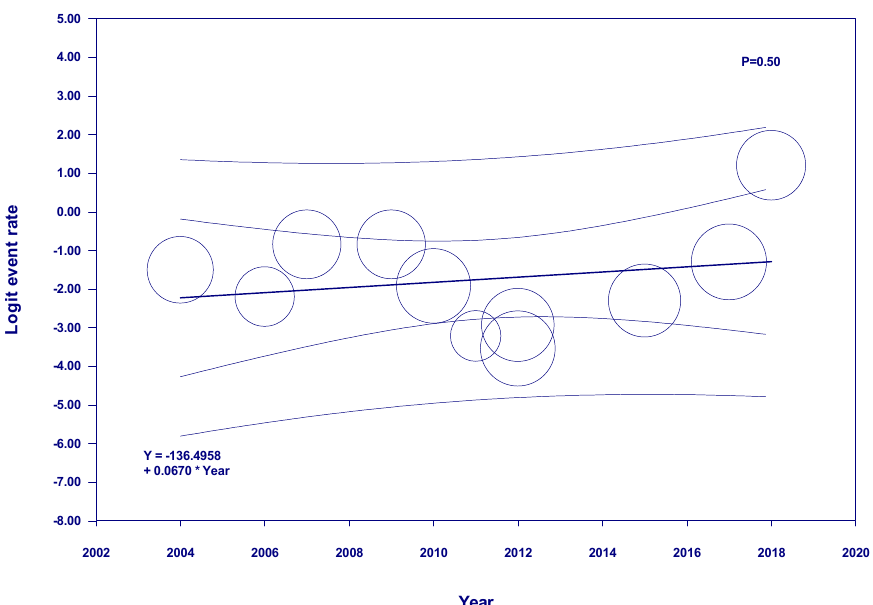
Figure 6. Meta-regression analyses showed no significant correlations between the year of study and mortality of patients with RCC ( P = 0.50). The solid line represents the weighted regression line based on variance-weighted least-squares. The inner and outer lines show the 95% confidence interval and prediction interval around the regression line. The circles indicate the log event rates in each study.